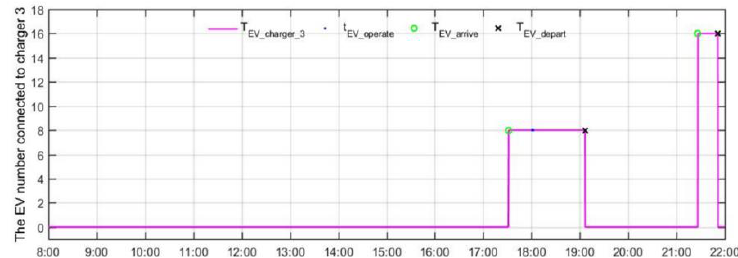
Figure 17. The operating time of EVs connected to charger 3 under ICDA.